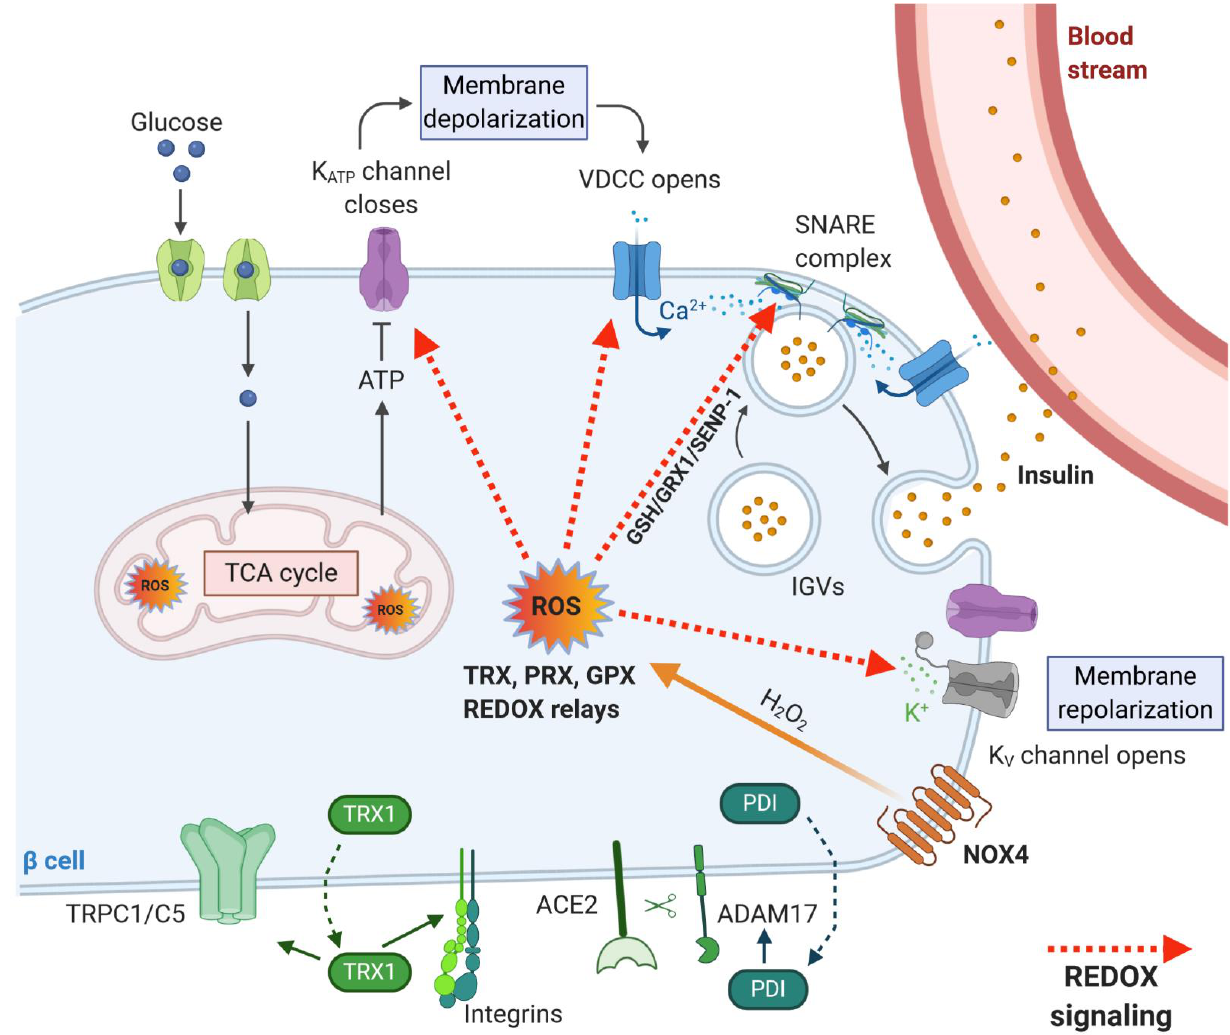
Figure 4. Redox targets within insulin secretory pathway and proteins involved in extracellular redox signaling. Glucose entry through GLUT1 in humans or GLUT2 in rodents causes an increase in ATP/ADP ratio and elevation of ROS production in the cytoplasm (mediated by NOX4). Subsequently, the K ATP channel closes, which causes depolarization of the plasma membrane, the opening of voltage-dependent calcium channels (VDCC) and Ca 2+ entry into the cells. Ca 2+ is required for insulin granule vesicles (IGV) trafficking, attachment and fusion with the plasma membrane (mediated by SNARE proteins) and finally, secretion of insulin from the cell. Repolarization of the membrane is mediated via voltage-gated K + channels (K V ). These repeating cycles lead to a high-frequency of action potential spikes and synchronized oscillations in the cytosolic Ca 2+ . ROS are utilized by redox-regulated proteins TRX, GPX and PRX, which can either neutralize the ROS action in the long-term or transform acute redox signal via redox relays. Targets of redox signaling involve K ATP channels, VDCC, K V channels and proteins involved in granule exocytosis. TRX1 and PDIs are secreted from β-cells, and they interact with extracellular domains of transmembrane proteins. PDIs regulate the action of sheddase ADAM17, and TRX1 modifies the activity of integrins and TRPC1/5 channels.